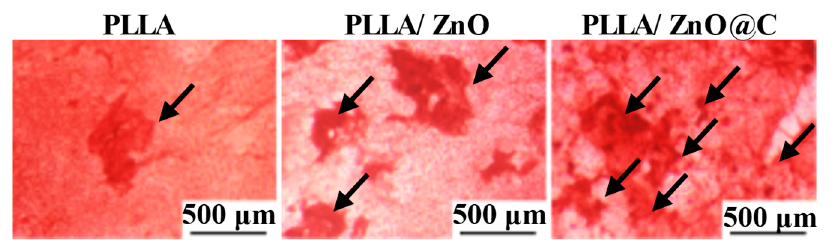
Figure 6. Images taken after the Alizarin Red staining procedure, the red precipitates were pointed by the black arrows.